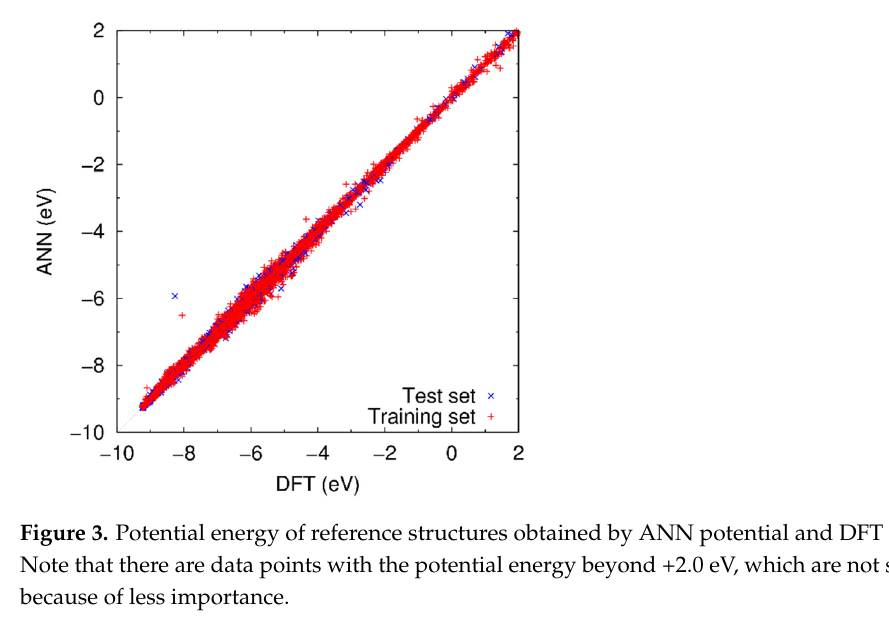
Table 2. Lattice constants ( a , c ), potential energy ( E ), and elastic constants ( C ij ) at equilibrium state of typical structures of SiC, Si, and C. Parameter d for C-graphene indicates the bond length. The column of “Exp.” and “MM” indicates the values obtained by experiments [47–51] and molecular mechanics simulation with conventional potential models (Tersoff (T94) [8], Erhart and Albe (EA) [9]), respectively.